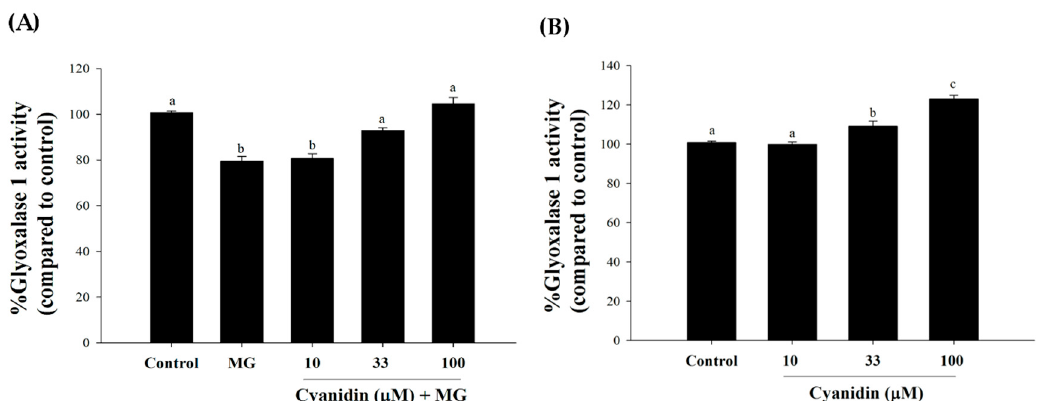
Figure 6. Effect of cotreatment of cyanidin and 500 µM methylglyoxal (MG) for 12 h on glyoxalase 1 (Glo-1) activity. ( A ) Cyanidin (33–100 µM) protected MG-induced decrease in Glo-1 activity. ( B ) Cyanidin (33–100 µ M) alone induced an increase in Glo-1 activity. Results are presented